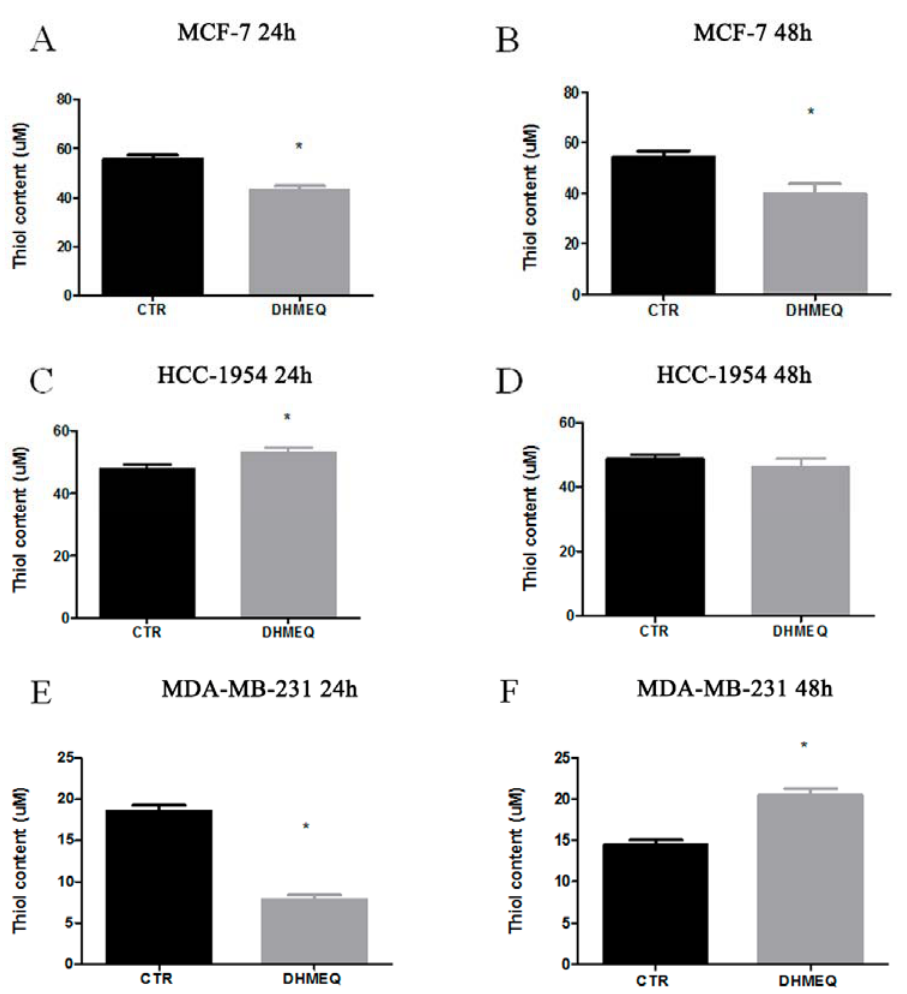
Figure 4. Thiol content. MCF-7 ( A , B ), HCC ( C , D ) and MDA-MB231 ( E , F ) cells treated (DHMEQ column) or not (CTR column) with NF- κ B inhibitor for 24 or 48 h. Data are expressed as the means and standard errors of the means. * indicates statistical significance ( p < 0.05).